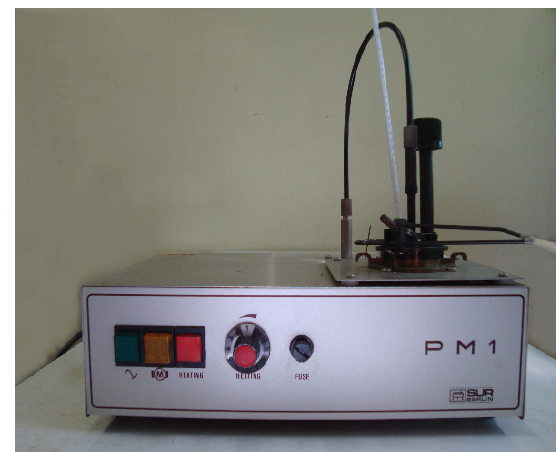
Figure 1. Photograph of the experimental